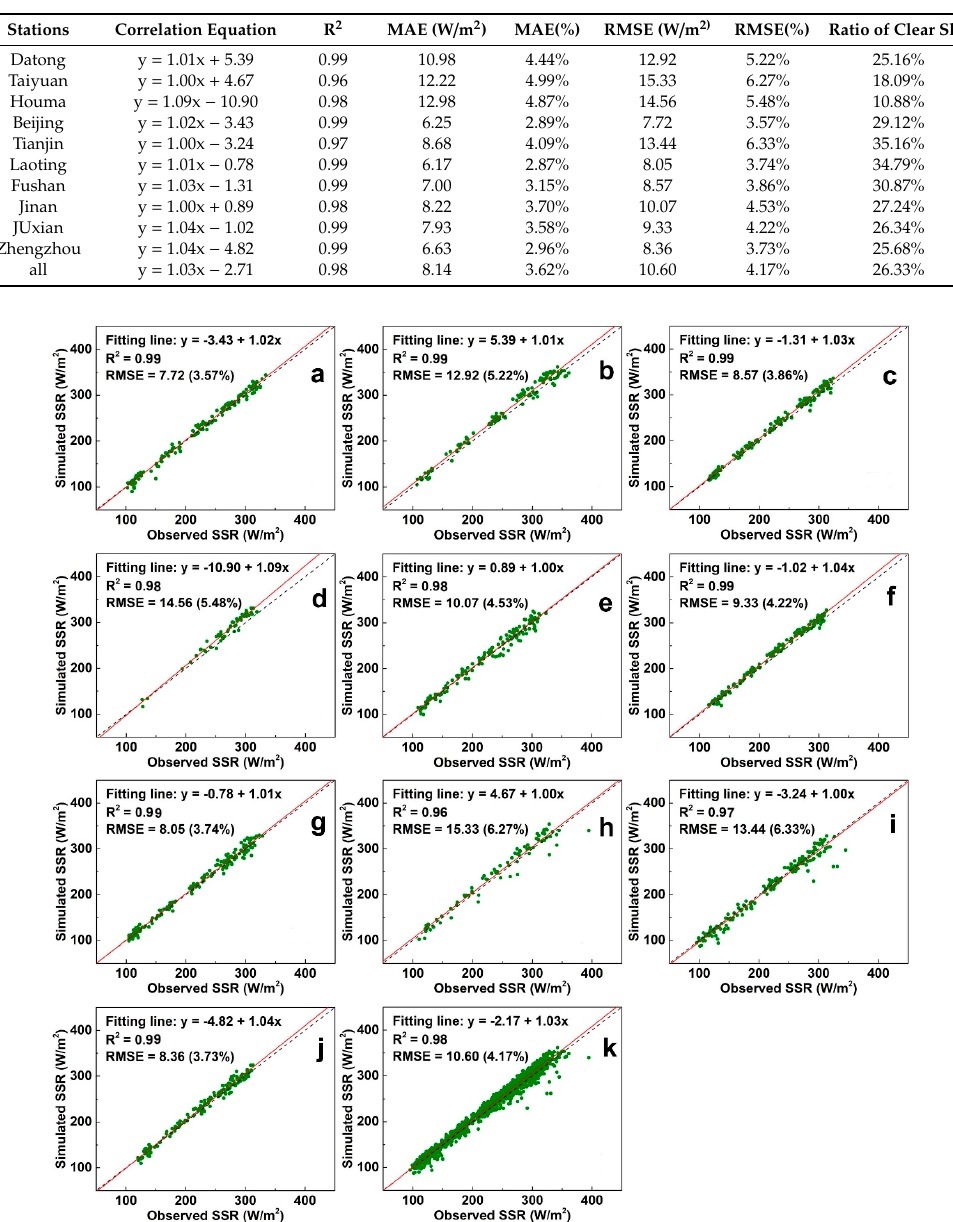
Figure 2. Comparison between monthly observed and simulated clear-sky surface solar radiation (SSR) at (a) Beijing; (b) Datong; (c) Fushan; (d) Houma; (e) Jinan; (f) JUxian; (g) Laoting; (h) Taiyuan; (i) Tianjin; (j) Zhengzhou; and (k) all the sites. Table 1. The statistical analysis between monthly observed and simulated clear-sky SSR.